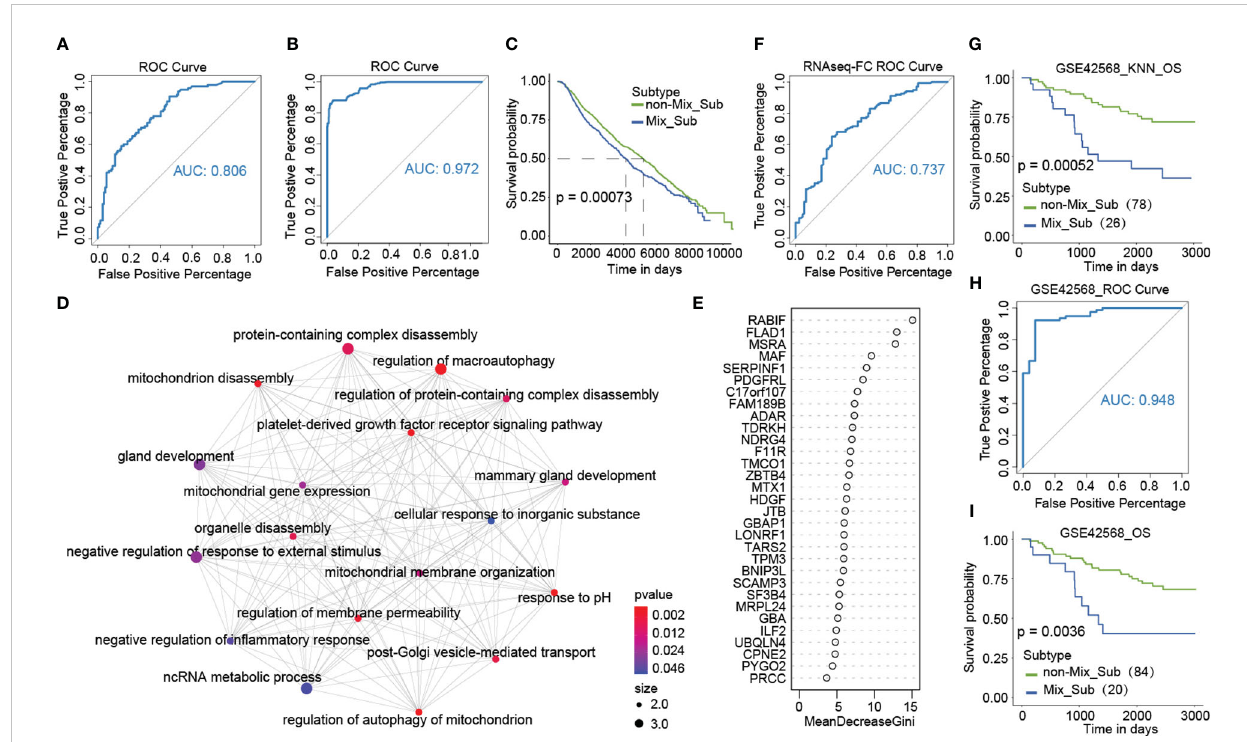
FIGURE 9 (A) ROC curves of classi fi ers constructed based on 31 marker genes. (B, C) ROC curves and Kaplan-Meier survival plots for validation of the Mix_Sub subtype classi fi er using external breast cancer data. (D) GO enrichment analysis of 31 marker genes. (E) Gini coef fi cient for 31 characteristics. (F) ROC curves of classi fi ers constructed based on expression fold changes of 18 marker genes. (G) Kaplan-Meier survival curve of K-nearest neighbor (KNN) classi fi cation results for the GSE42568 dataset. (H, I) Using the grouped GSE42568 dataset, the ROC curves for validating the broad applicability of the Mix_Sub subtype classi fi er and Kaplan-Meier survival curve for classi fi cation